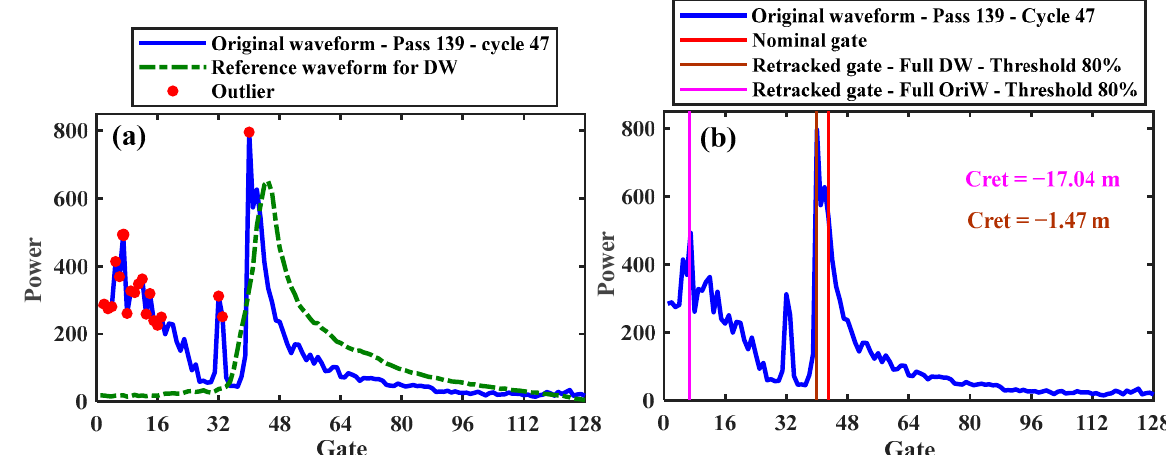
Figure 10. ( a ) Reference and original waveforms with detected outliers for a waveform of pass 139 in cycle 47 over the Persian Gulf, ( b ) retracked gates/corrections of the decontaminated and original waveform derived from the threshold retracker.